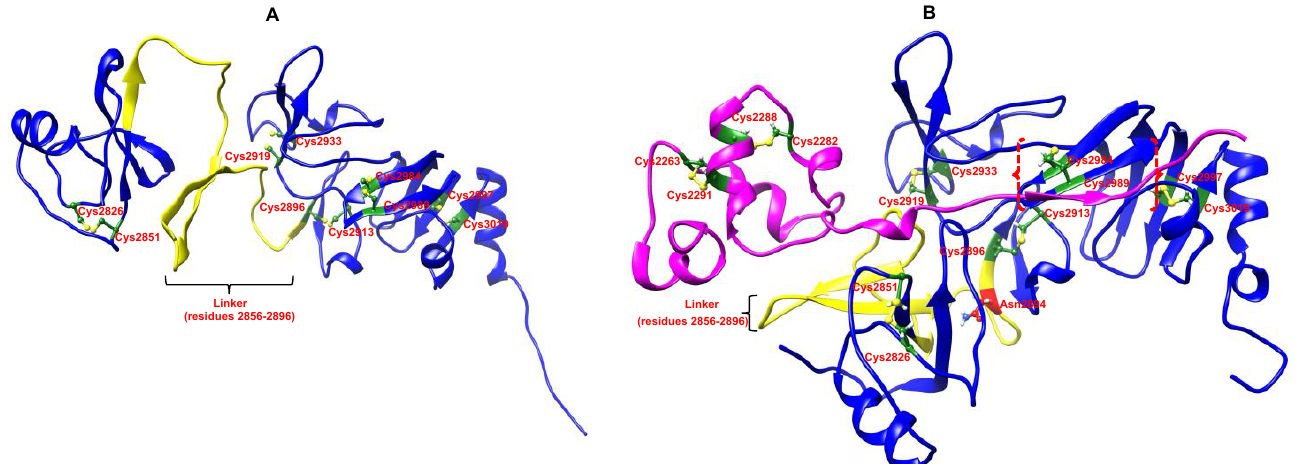
Figure 3. ( A ) Predicted structure of the nsp4 (blue) lumenal region (alone). Cysteine residues are highlighted in green while the linker region is coloured yellow. ( B ) nsp3 (magenta) and nsp4 (blue) lumenal regions predicted in complex with the linker region are highlighted in yellow while the cysteine residues are highlighted in green. Red curly-bracketed regions show a β -strand (residues 2309–2311) in the nsp3 lumenal region that interacts as a β -sheet with a β -strand (residues 2988–2992) in the nsp4 lumenal region. The atypical glycosylation site at Asn 2894 is coloured in red. The disulphide bonds between the cysteine residues are also highlighted in yellow. Table 3 indicates the set of residue – residue interactions observed in Figure 3B be- Table 1. The β -strands and their partners in the linker (residues 2856–2896) of the nsp4 lumenal tween nsp3 and nsp4. Most of these represent hydrogen bonding interactions. region predicted alone using ColabFold. Table 3. Residue sidechain interactions between the nsp3 lumenal region and the nsp4 lumenal β -Strand in the Linker region (both without transmembrane regions). For each sidechain interaction, a tick ( ✓ ) in one of the three columns on the right indicates if it is also present in one of the models of the nsp3 and nsp4 lumenal regions complexed with and without transmembrane regions.